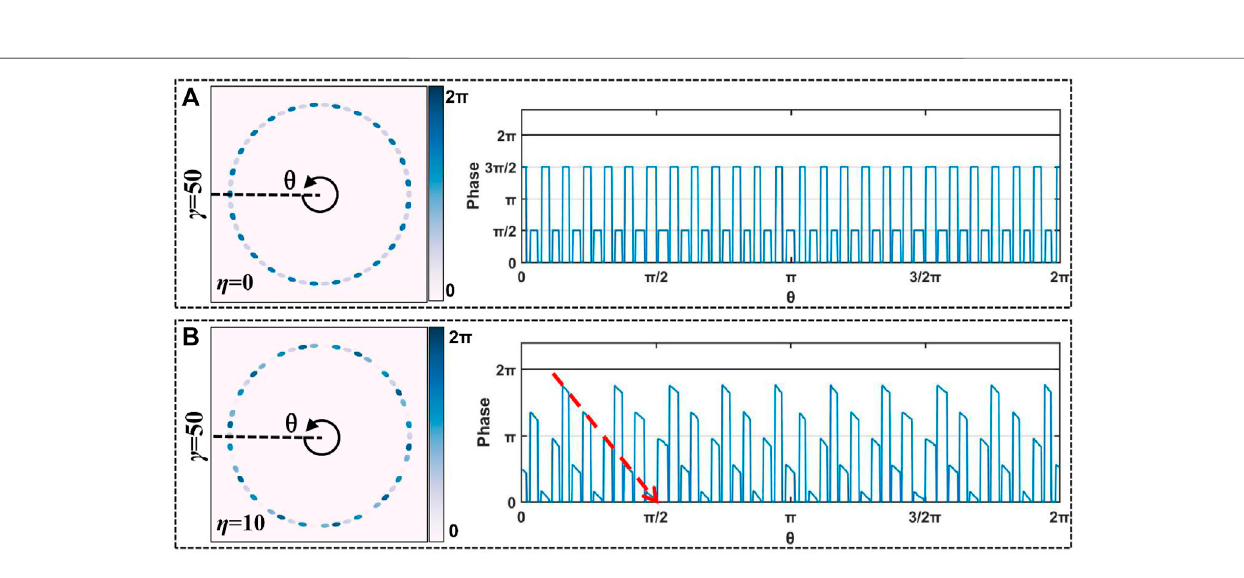
Frontiers in Physics |